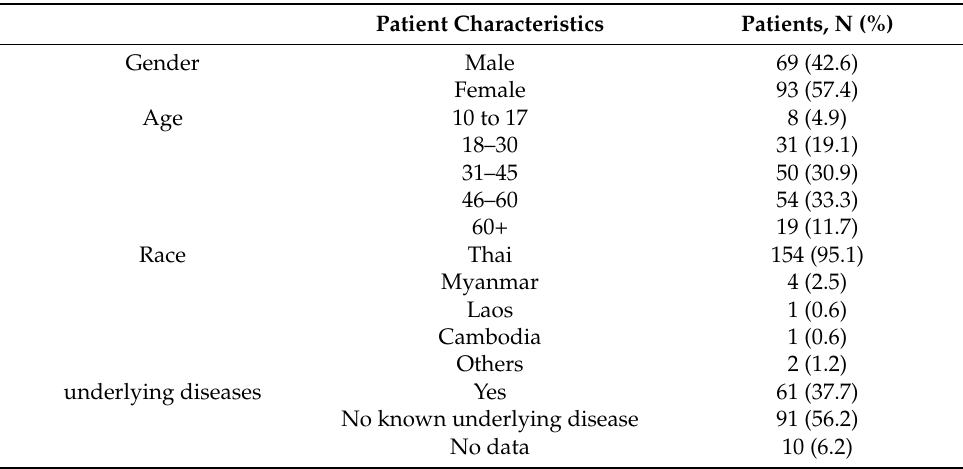
Table 1. Demographic data of the CHIKV-infected patients (N =